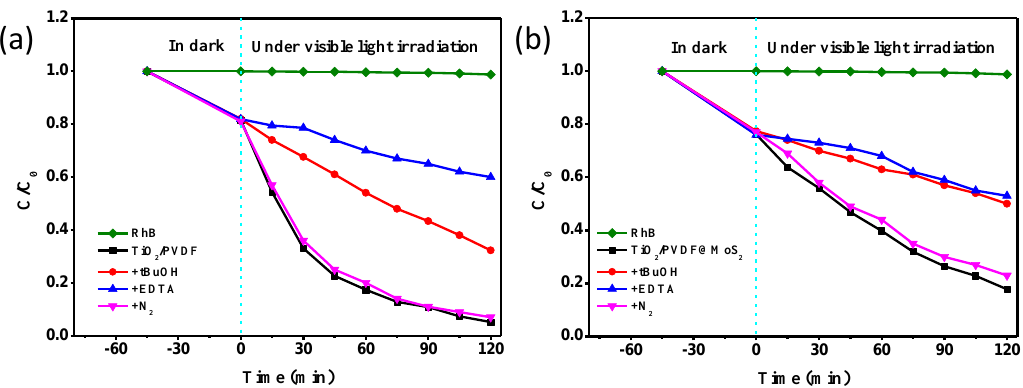
Figure 11. Control experiments with radical scavengers. ( a ) The relative concentration variation plots of RhB solution using TiO 2 /PVDF fibers as the photocatalyst. ( b ) The relative concentration variation plots of RhB solution using TiO 2 /PVDF@MoS 2 fibers as the photocatalyst.